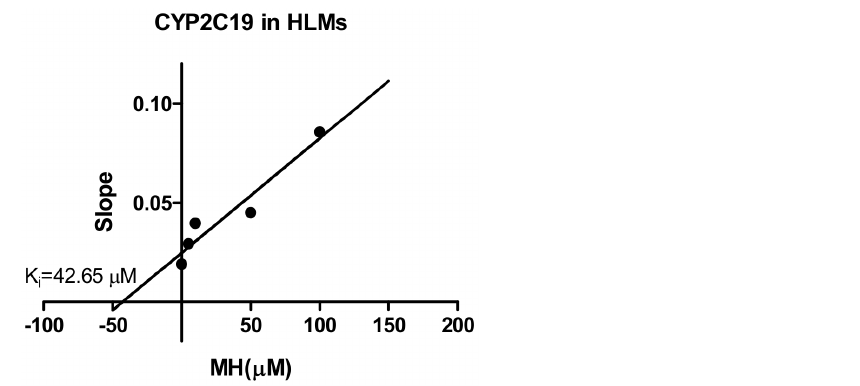
Figure 8. Secondary plot of CYP2C9 activity using the slopes of the primary Lineweaver-Burk plots versus concentrations of MH. Note: illustrating the effects of MH on the metabolism of S-Mephenytoin via 4- hydroxylation in human liver microsomes. Each point represents the mean of triplicate